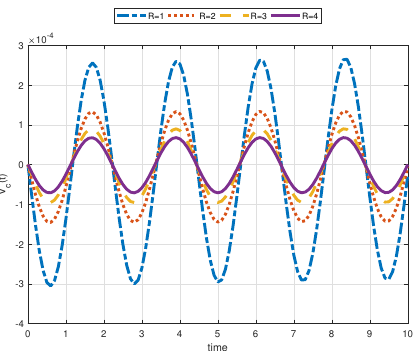
Figure 7. This figure corresponds to the function V c ( t ) with an oscillatory source for some values of α , ρ , and γ in order to show the effect of resistance on solution curves when α = 1, ρ = 1, γ = 1, C = 10 F, e 0 = 10 V, and θ = 60 Hz, V c ( 0 ) =